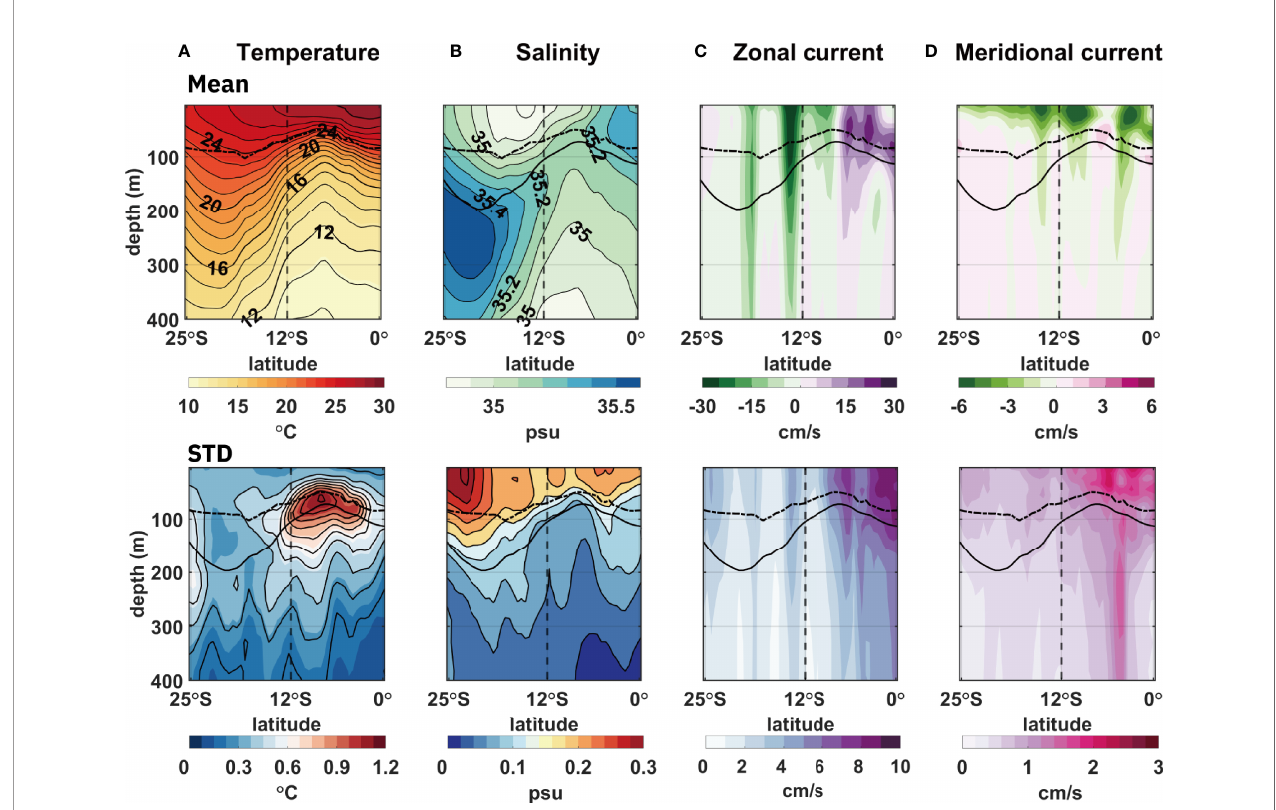
FIGURE 2 | Meridional distribution of the (top) means and (bottom) standard deviations of the ocean environmental variables for 1990 – 2014, zonally averaged from 54°E to 60°E in the SWTIO. The standard deviations were calculated from the annual means of the variables. Each column represents a different variable: (A) temperature, (B) salinity, (C) zonal current velocity, and (D) meridional current velocity. The thick dashed/dotted lines and solid lines indicate the mean thermocline depth and 20°C isotherm depth (D20), respectively. The vertical dashed lines denote 12°S, the boundary between the northern and southern regions of the